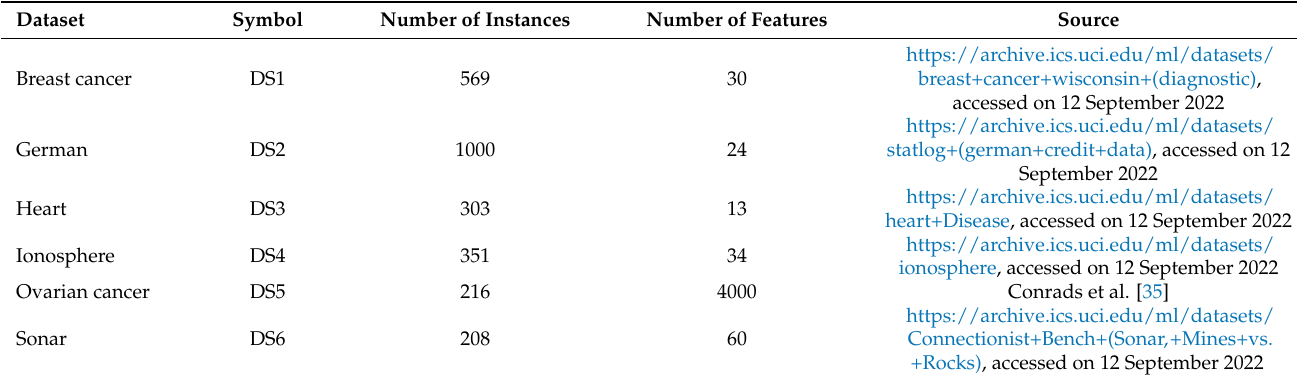
Table 1. Datasets selected for this